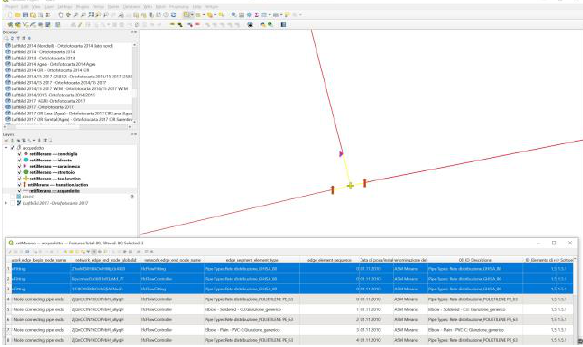
Figure 6. Result in QGIS of SPARQL endpoint for geometric and alphanumeric description (source: R3GIS